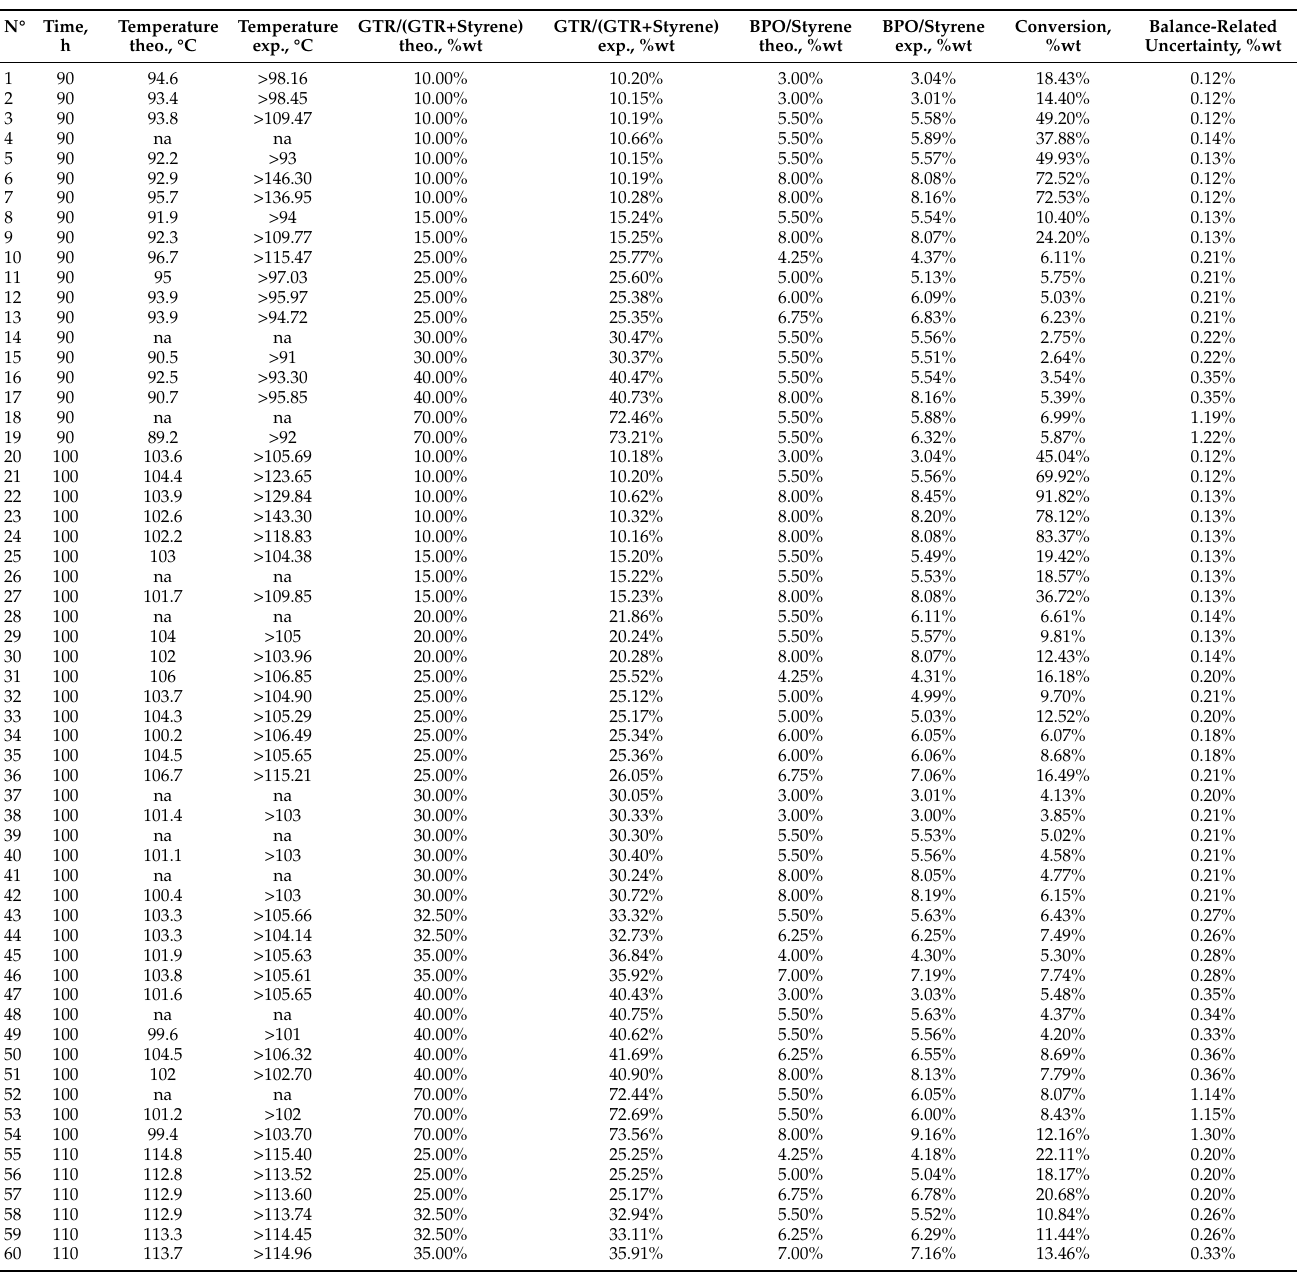
Table C2. Experimental results for the medium-sized